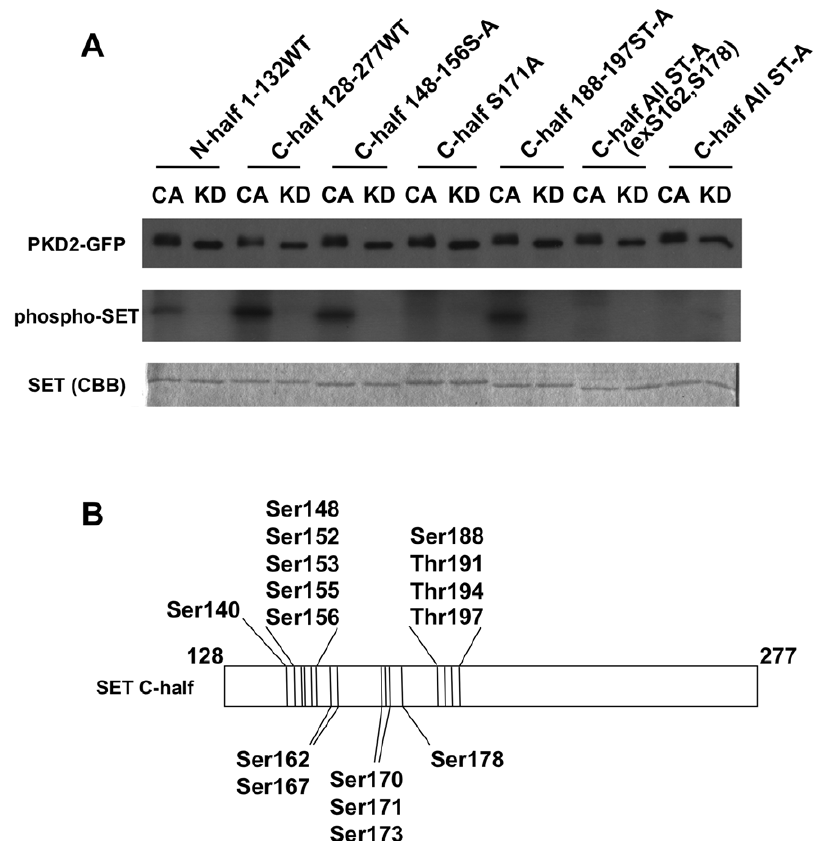
Figure 3. Ser171 of SET is phosphorylated by PKD2. (A) The indicated 6 6 His-tag SET mutant proteins were treated with immunoprecipitated constitutively active-PKD2-GFP (CA) or kinase dead-PKD2-GFP (KD) in the presence of [ c - 32 P]-ATP. The kinase assay mixture was analyzed with SDS- PAGE. Immunoprecipitated PKD2-GFP was blotted with anti-GFP antibody (upper panel) to monitor equal loading of the PKD2 mutants. Phosphorylation of the SET mutants was monitored by incorporated radioactivity (middle panel). Equal loading of each SET mutant protein was confirmed by staining with Coomassie Brilliant Blue (CBB, lower panel). The data shown are representative results from three independent experiments with similar results. (B) A diagram of Ser/Thr residues present in C-terminal half (128–277) of SET protein.